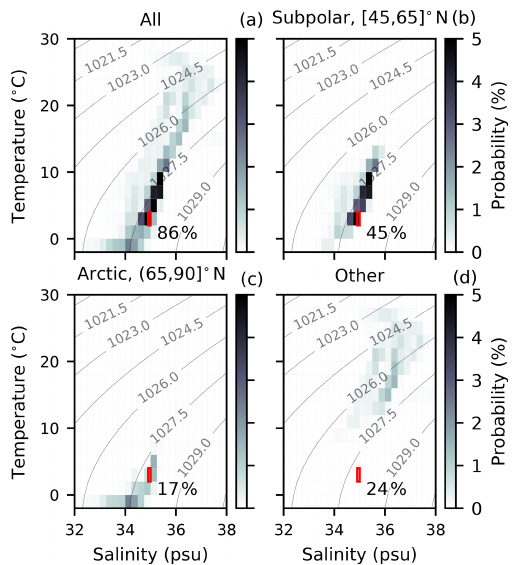
Figure 18. As in Fig. 9 but for NADW and a time period of [0,400] years. (a) NADW total volume. (b) NADW volume traced to the subpolar North Atlantic. (c) NADW volume traced to the Arc- tic. (d) Volume of NADW originating